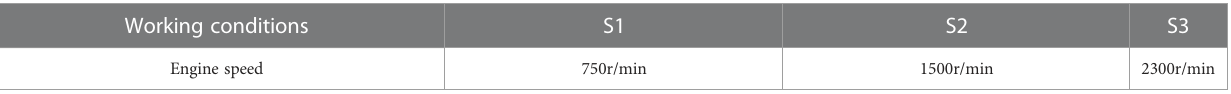
TABLE 2 Engine speed under different working conditions.